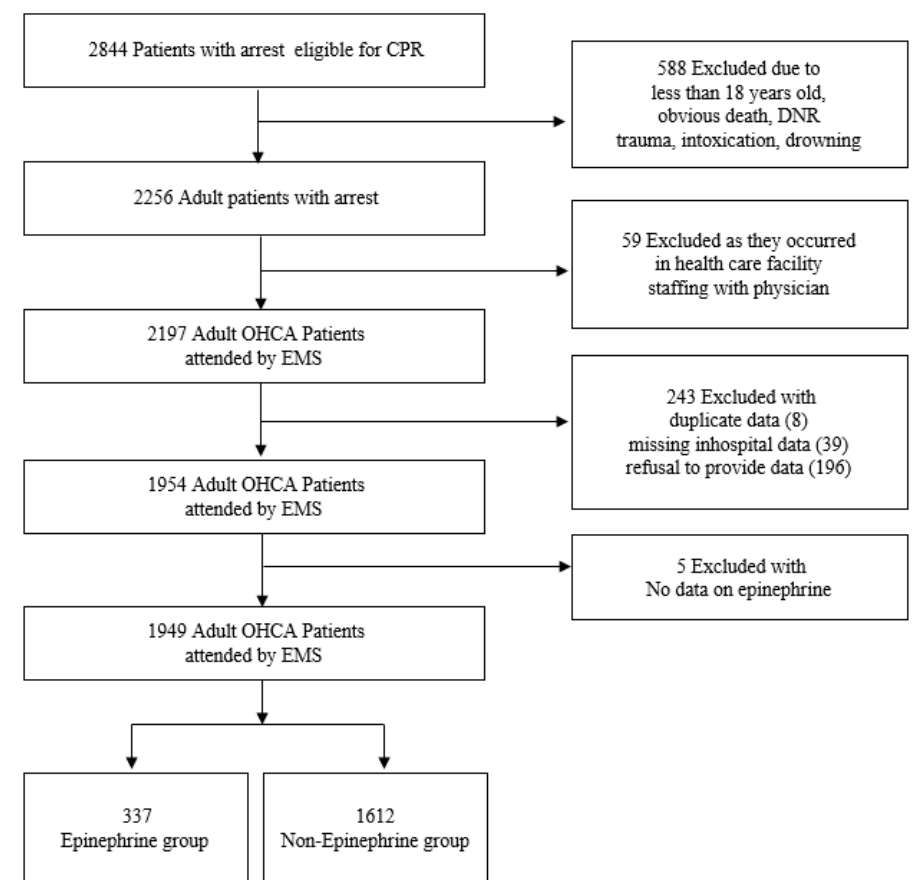
Figure 1. The flow chart of the study population. CPR, cardiopulmonary resuscitation; OHCA, out-of-hospital cardiac arrest; EMS, emergency medical service; DNR, do not resuscitate. Characteristics of the total study population and 1:1 propensity-matched population.